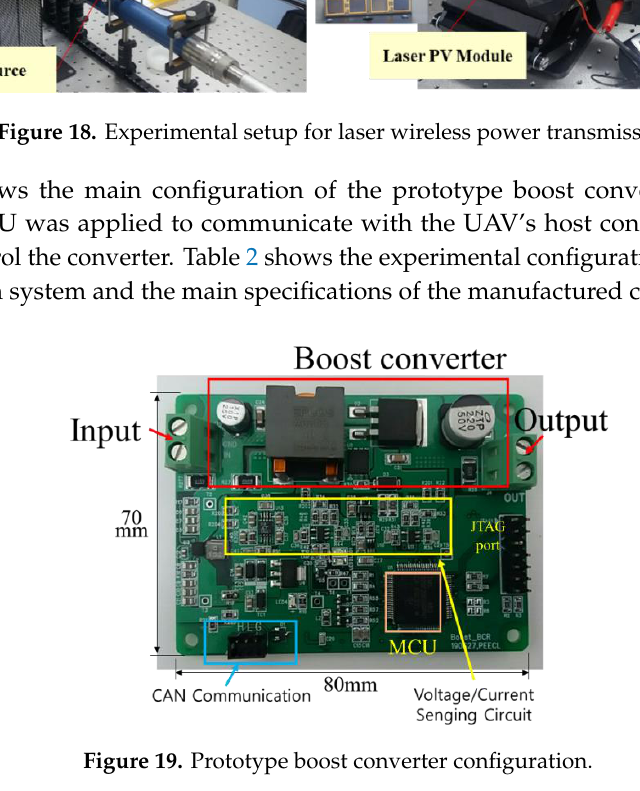
Figure 19. Prototype boost converter configuration.